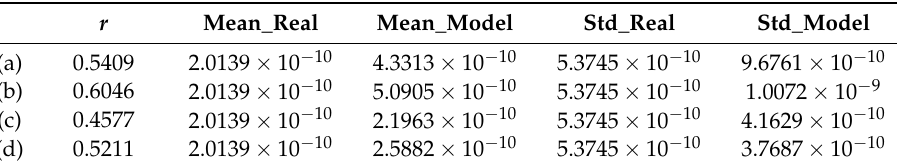
Table 3. Correlation coefficients, the mean values and standard deviations corresponding to Figure 3. ( r means correlation coefficients between observations and model predictions; Mean_real and Mean_model represent mean value for real observations and model respectively; similarly, Std_real and Std_model represent standard deviation for real observations and model.).